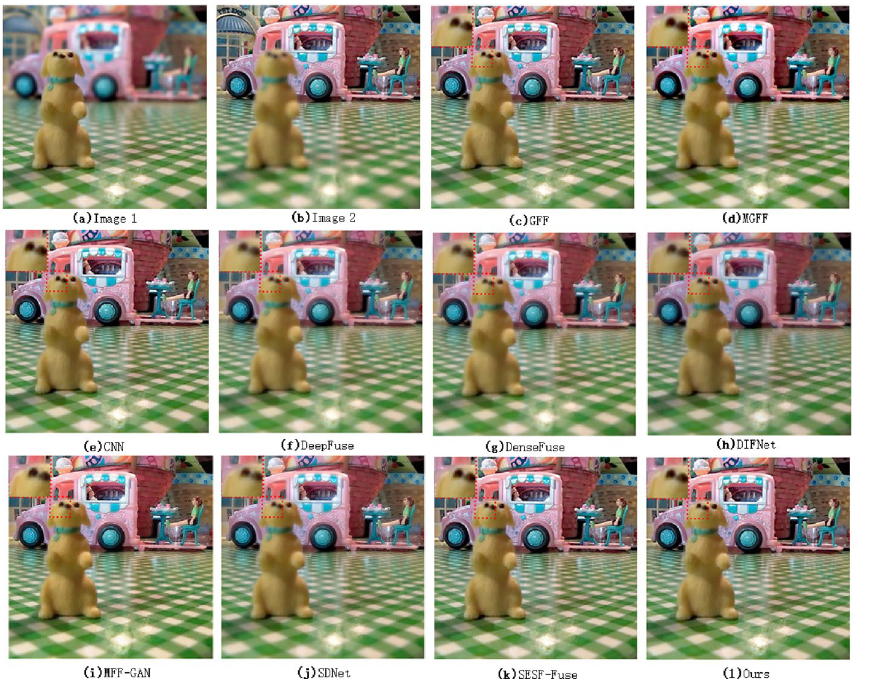
Figure 3. Image local comparison 1(Lytro 17 35